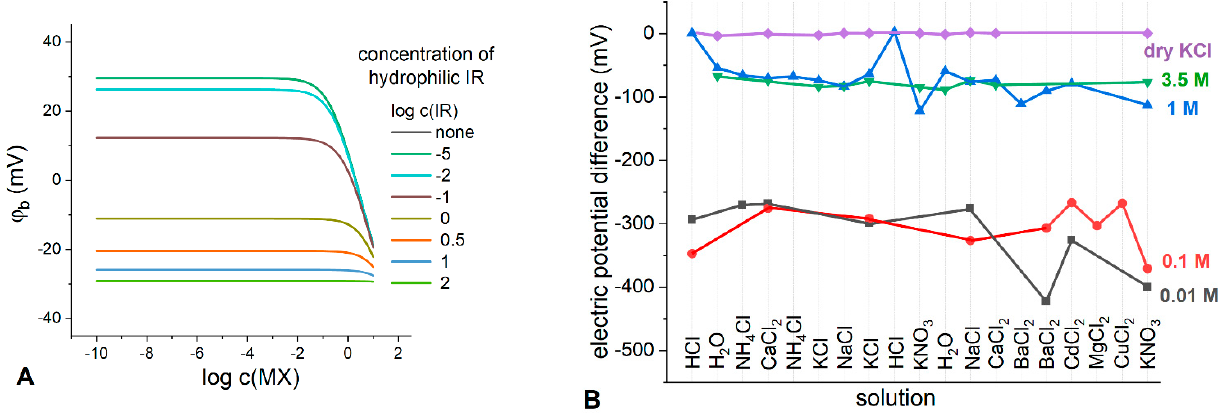
Figure 8. ( A ) Simulated boundary potential for the membranes containing Q + B − and hydrophilic electrolyte (IR) added to the membrane in various concentrations (indicated in the plot). c ( QB ) = 0.15 M; k I = 10 − 5 , k R = 10 − 4 ; k Q = 10 3 , k B = 10 2 ; V m = 10 − 5 L, V aq = 1.5 · 10 − 6 L; k M = 10 − 6 , k X = 10 − 4 . ( B ) Experimental response of the electrodes with lipophilic electrolyte TBATBB and salt KCl in the membrane, in various electrolyte solutions (indicated in the plot). Soaking solutions: 0.01 M KCl (black curve), 0.1 M KCl (red curve), 1 M (blue curve), 3.5 M (green curve); violet curve: KCl was added as dry salt into the membrane.